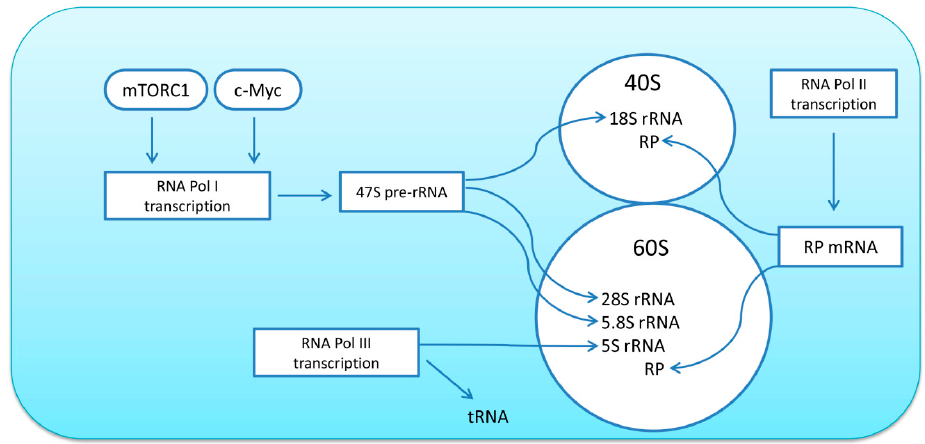
Figure 1. Simplified diagram showing the key regulatory factors involved in ribosome biogenesis. Arrows indicate stimulatory signals. mTORC1—mammalian/mechanistic target of rapamycin